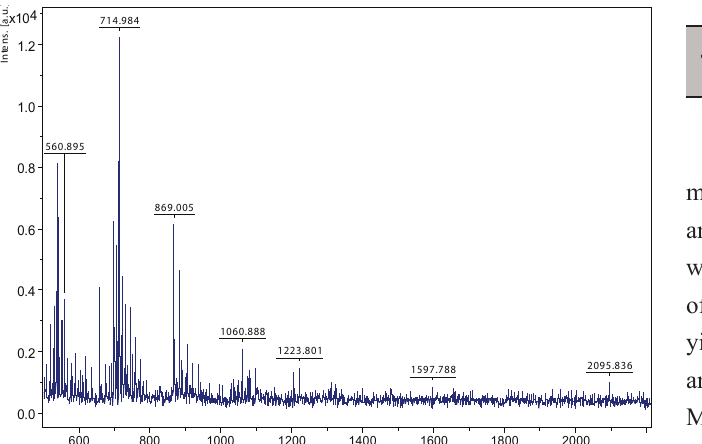
FIGURE 2 - MALDI-TOF spectrum of the Peak 7.